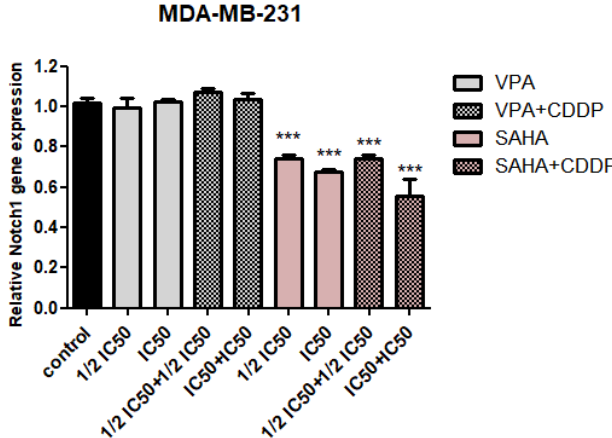
Figure 3. The mRNA expression level of Notch1 in MDA-MB-231 breast cancer cells after (histone deacetylase inhibitors) HDIs and CDDP treatment. Expression of Notch1 was analyzed by qPCR in MDA-MB-231 cells exposed to the culture medium alone (control), VPA ( 1